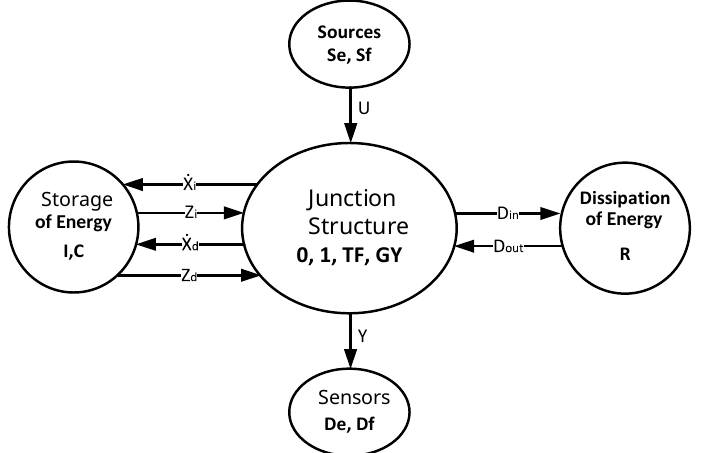
Figure A1. Structural bond graph